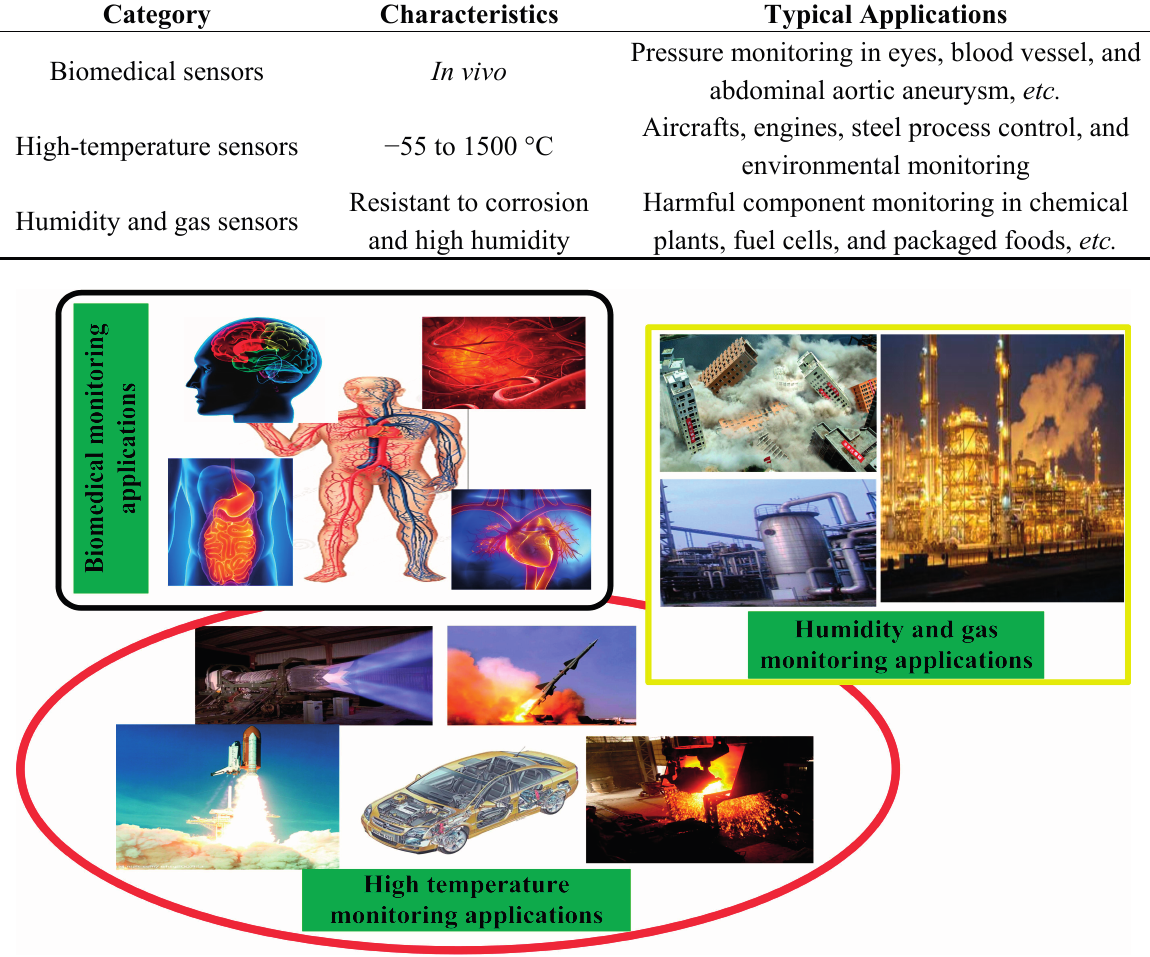
Figure 1. Examples of high-temperature, biomedical, and humidity and gas monitoring applications in harsh